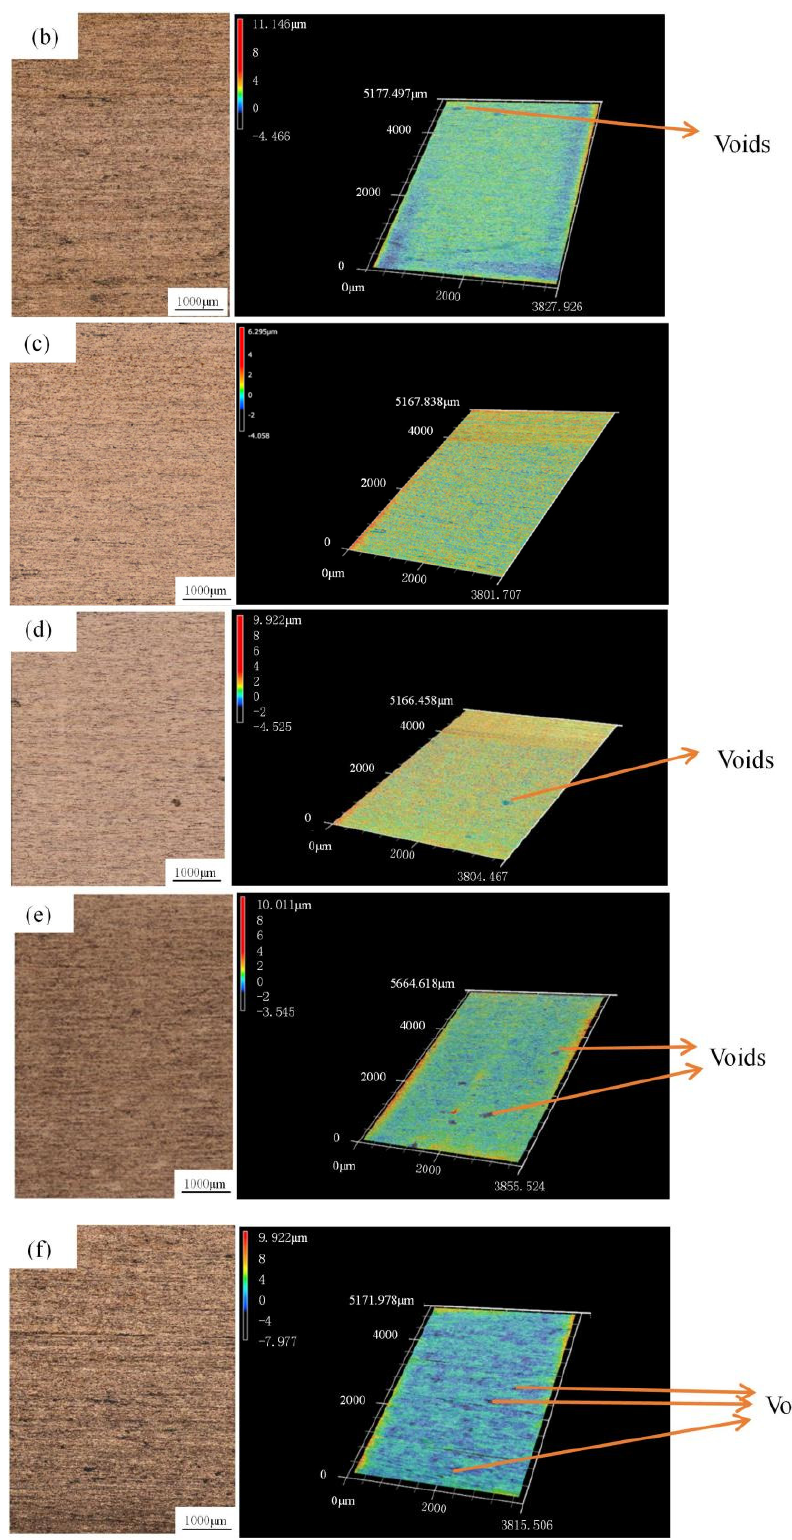
Figure 4. 3D surface topographies of rolled copper foils (50% reduction) under ( a ) dry conditions, ( b ) 1.0 wt%, ( c ) 3.0 wt%, ( d ) 5.0 wt%, ( e ) 7.0 wt% and ( f ) 9.0 wt%. ( b ) 1.0 wt.%, ( c ) 3.0 wt.%, ( d ) 5.0 wt.%, ( e ) 7.0 wt.% and ( f ) 9.0